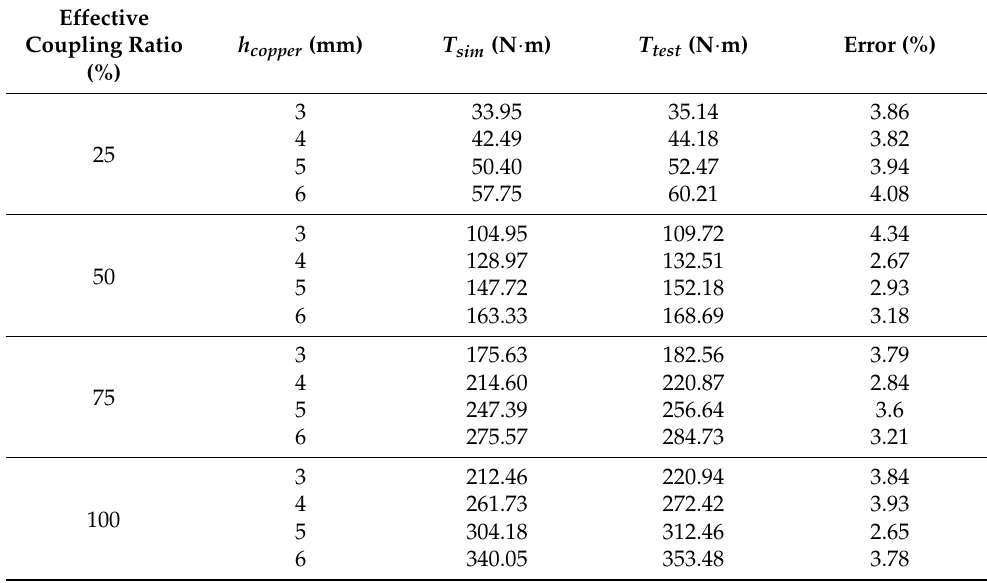
Table 5. Comparison of experimental and simulation results of output torque under different copper ring